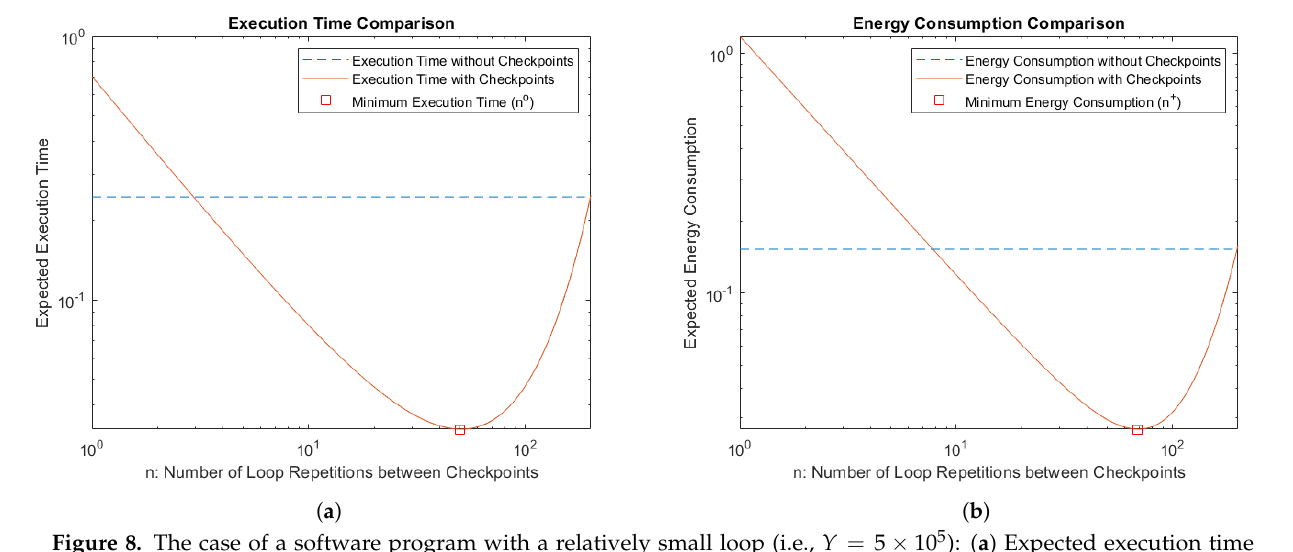
Figure 8. The case of a software program with a relatively small loop (i.e., Y = 5 × 10 5 ): ( a ) Expected execution time comparison (logarithmic axes) ( b ) Expected energy consumption (logarithmic